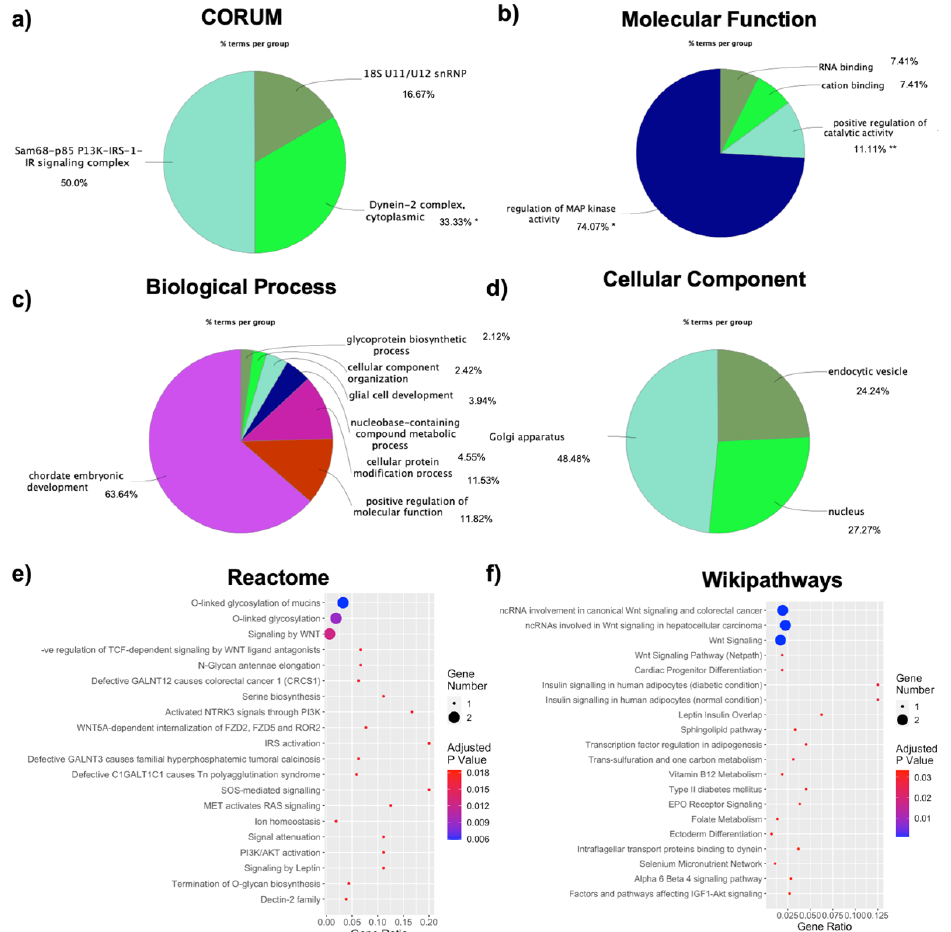
Figure 7. Characterization of enrichment in ncRNAs-related DE RNAs: ( a ) CORUM protein com- plexes analysis and GO enrichment analyses for ( b ) molecular function, ( c ) biological processes, and ( d ) cellular component, displayed as ClueGO graphs. Each pie segment refers to the % of terms present per group; * p < 0.05 and ** p < 0.01. Pathways analysis with Reactome ( e ) and Wikipathways ( f ) databases, represented as a dotplot, where the y-axis represents the name of the pathway, the x- axis represents the gene ratio, dot size represents the number of genes, and the color indicates the adjusted p -value.